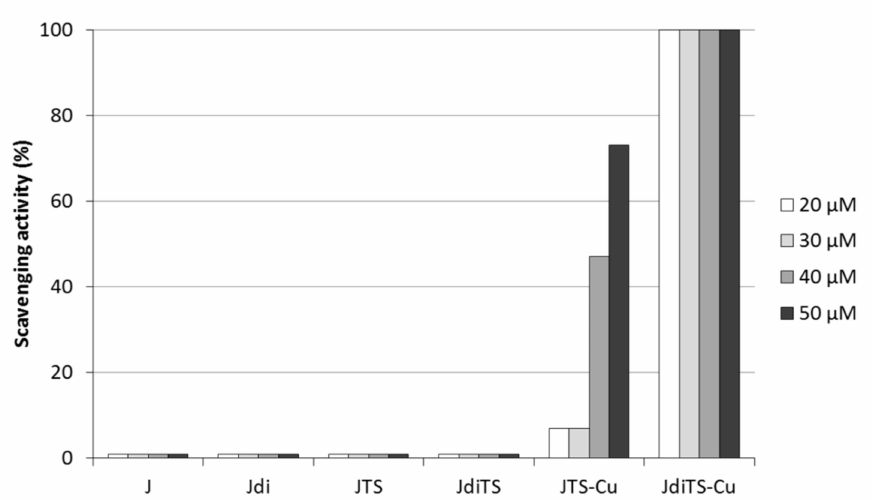
Figure 2. Scavenging assay (2,2-diphenyl-1-picrylhydrazyl radical (DPPH)). The in vitro antioxidant ability of compounds is expressed as percentage of inhibition with respect to ascorbic acid 30 mM scavenging activity